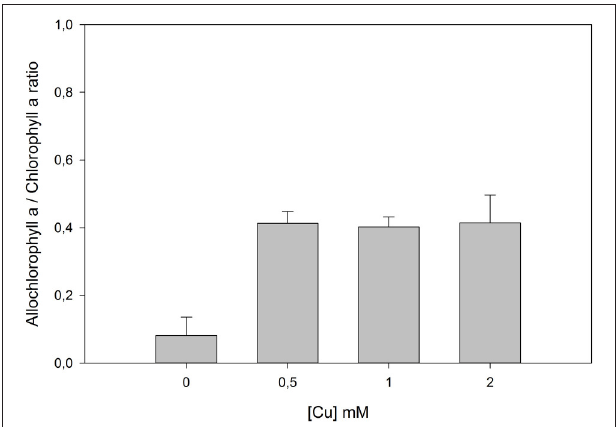
Frontiers in Environmental Science |